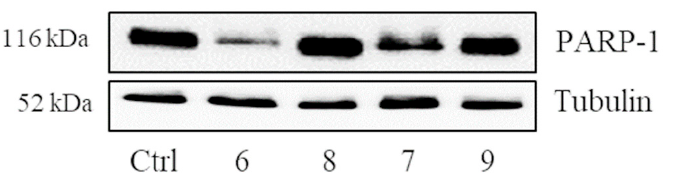
Figure 3. Western blot analysis of PARP-1 expression in MSTO-211H cells (whole cell lysate) after treatment (72 h) with diluent (Ctrl) or compounds 6 – 9 at their IC 50 values. Tubulin was used as loading control.